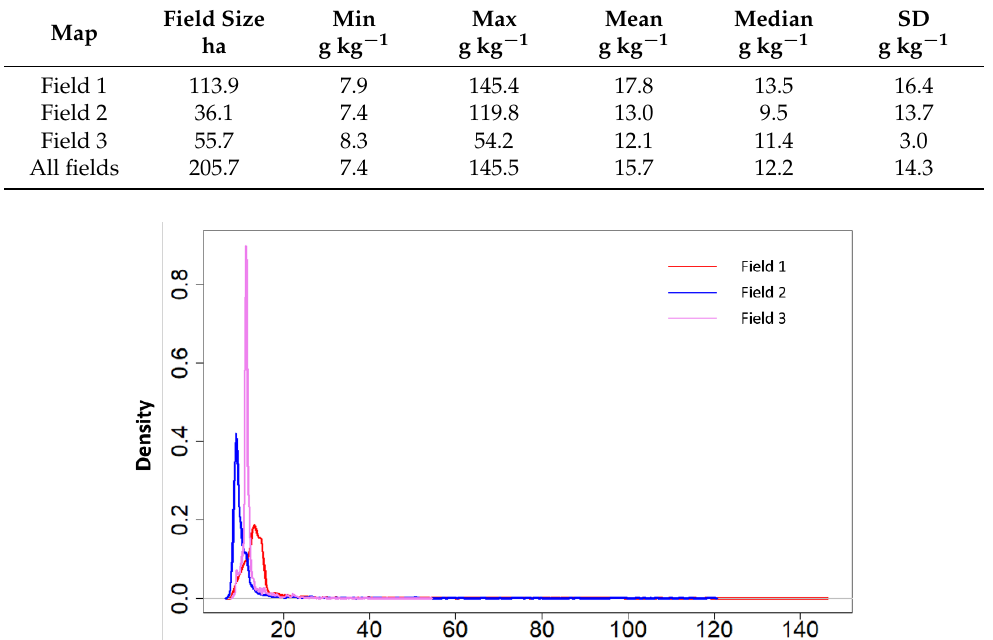
Table 1. Descriptive statistics of the soil organic carbon content maps of the field 1, 2 and 3adapted from [34].